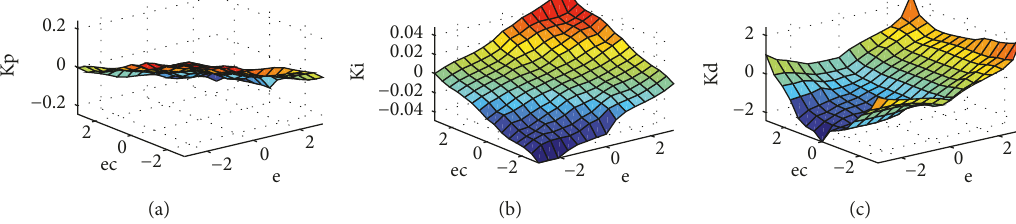
Figure 5: The surfaces of the parameters with 𝑘 𝑝 , 𝑘 𝑖 , and 𝑘 𝑑 . (a) is the surface of 𝑘 𝑝 , (b) is the surface of 𝑘 𝑖 , and (c) is the surface of 𝑘 𝑑 . The horizontal axis 𝑥 is 𝑒 and the vertical axis 𝑦 is ec in all the three diagrams.